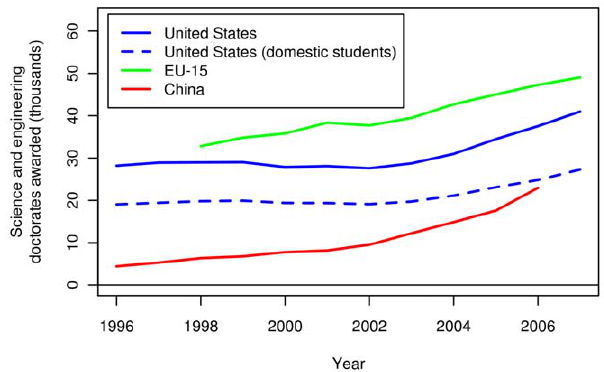
Figure 8. Per capita government spending on research and development in the US, the EU-27 and China. Federal govern- ment spending on R&D per person, in inflation adjusted dollars, from 1996 to 2007 for the US, the EU-27 and China. Per capita figures were divided by the population of the region.